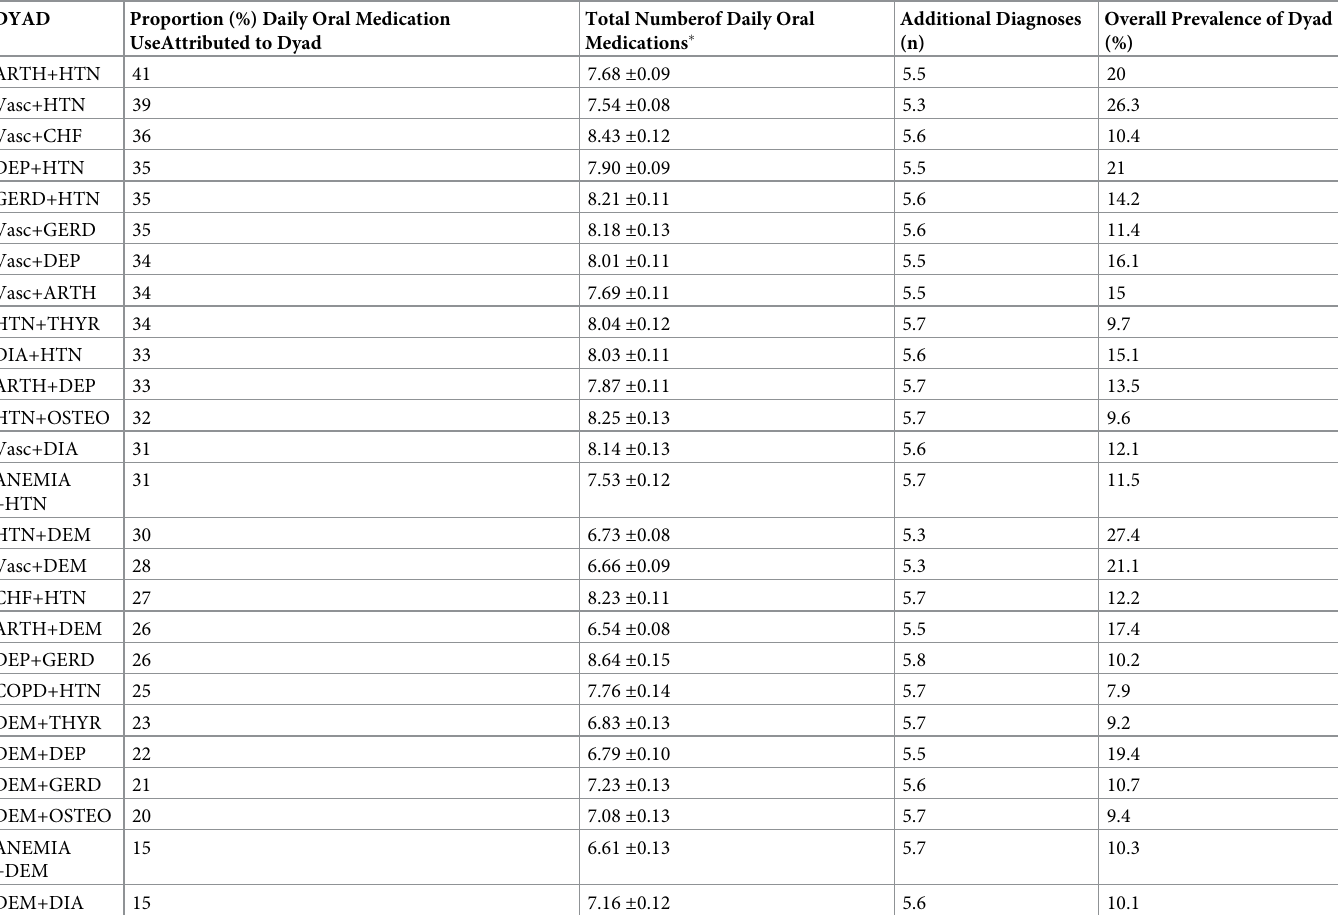
Data represent co-morbid 2-disease combinations present in over 5% of either men or women. HTN = hypertension, DEM = dementia, DEP = depression, ARTH = Arthritis, DIA = diabetes mellitus, GERD = gastroesophageal reflux and acid peptic disorders, CHF = congestive heart failure, THYR = thyroid disease, OSTEO = osteoporosis, COPD = chronic obstructive pulmonary disease, Vasc = composite of vascular diseases (atherosclerosis, cerebrovascular disease, coronary artery disease, peripheral artery disease). (cid:3) mean ±